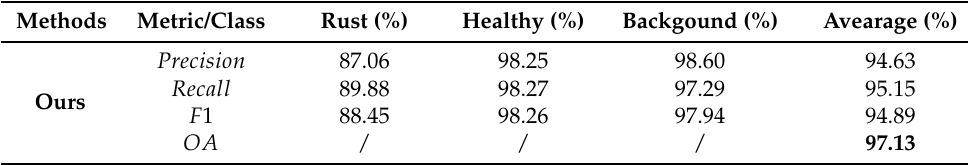
Table 10. Performance with inputs A using